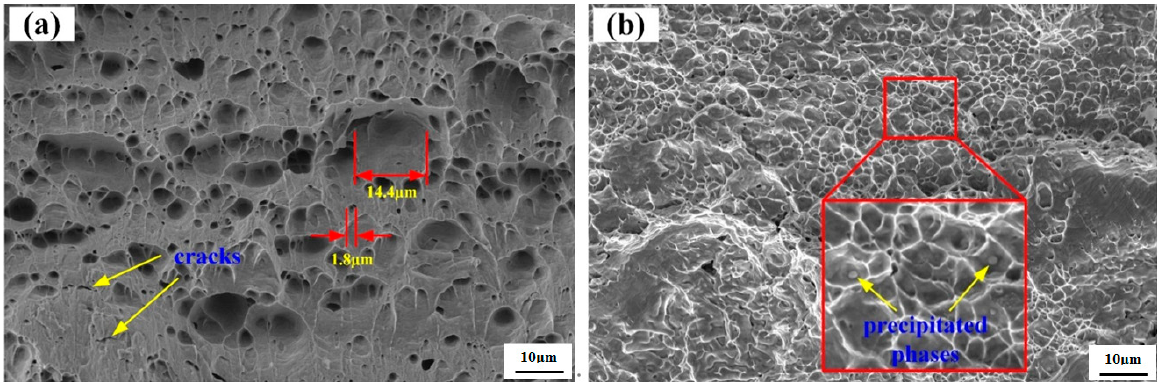
Figure 6. Fractographs of tested samples at room temperature: ( a ) laser welding; ( b ) laser oscillating welding.